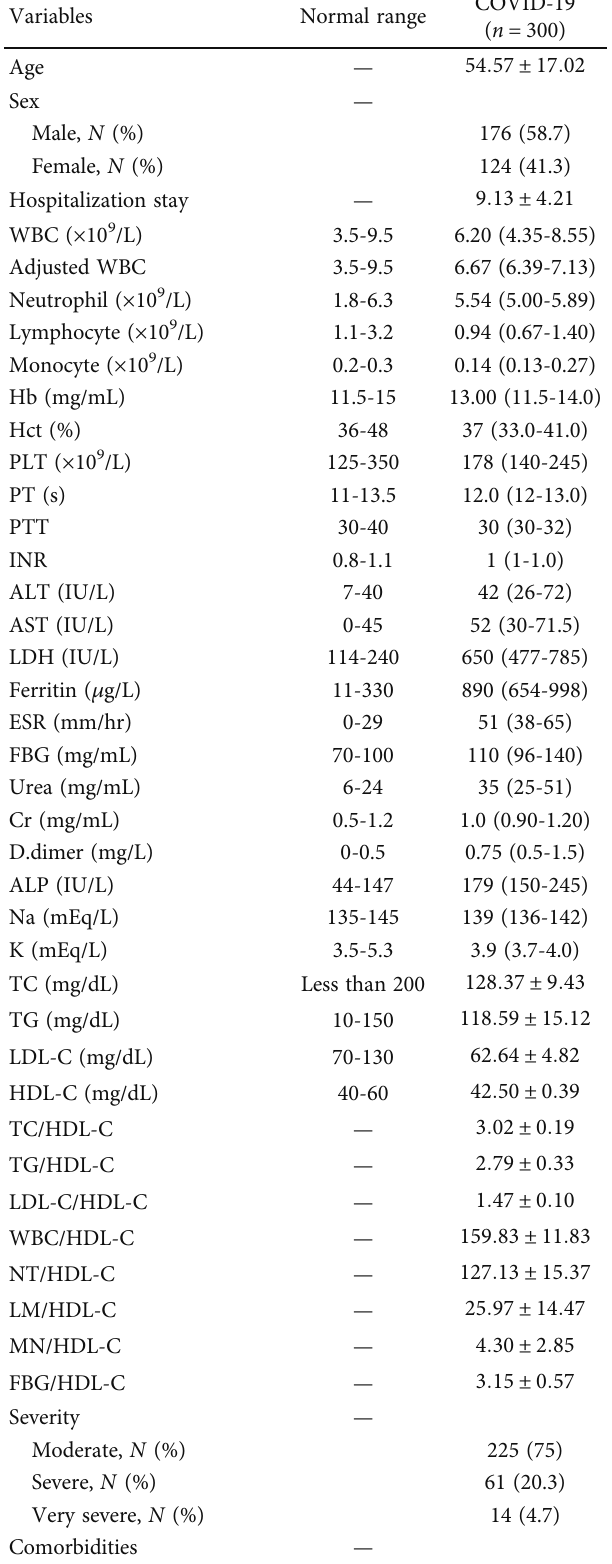
Table 1: Demographic, hematological, lipid pro fi le and its relative ratios of COVID-19.